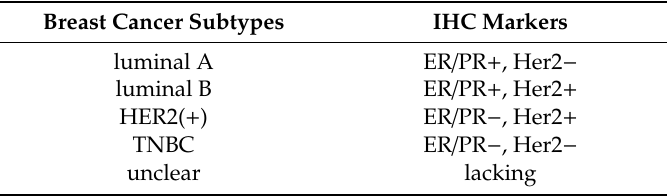
Table 1. The detailed definition of breast cancer